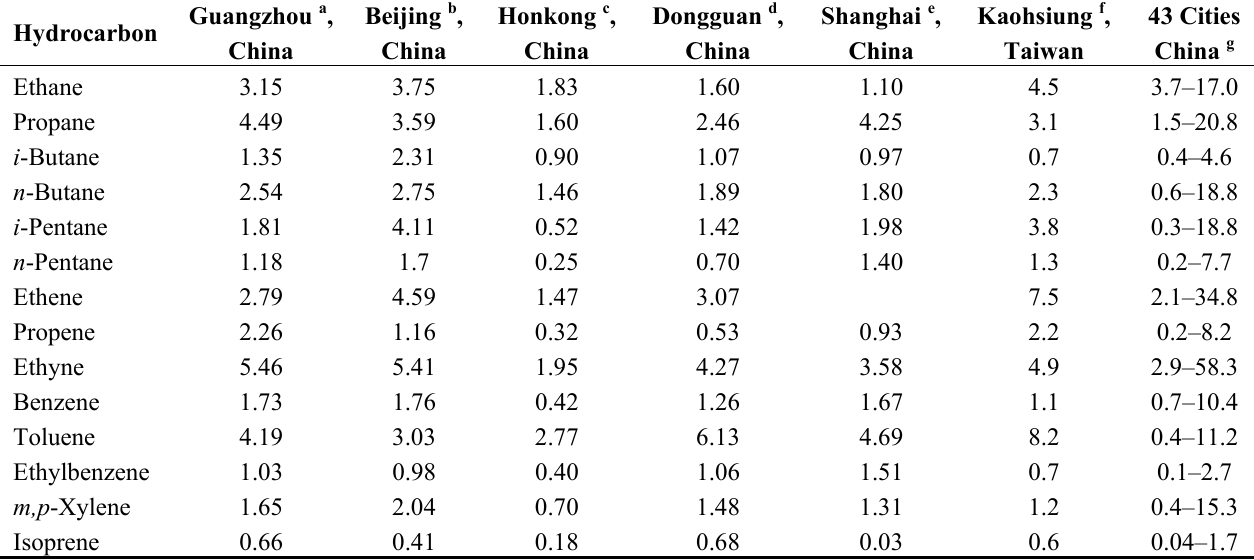
Table 2. Comparison of selected NMHCs in Guangzhou with other cities (units: ppbv).